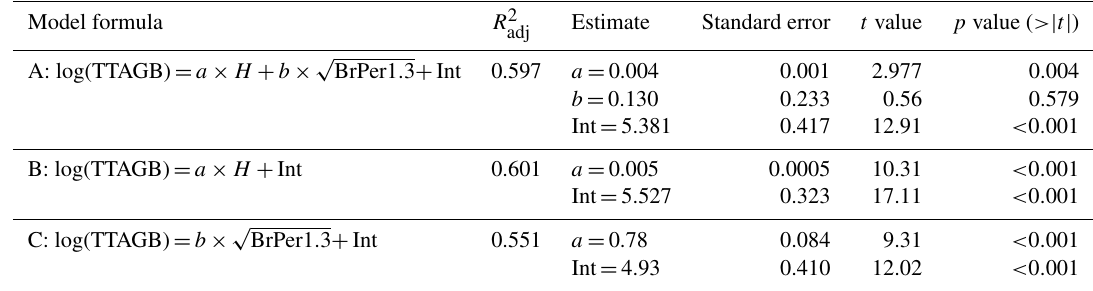
Table A1. Statistics of the models for reconstructing total tree (larch) AGB. Model formula R 2